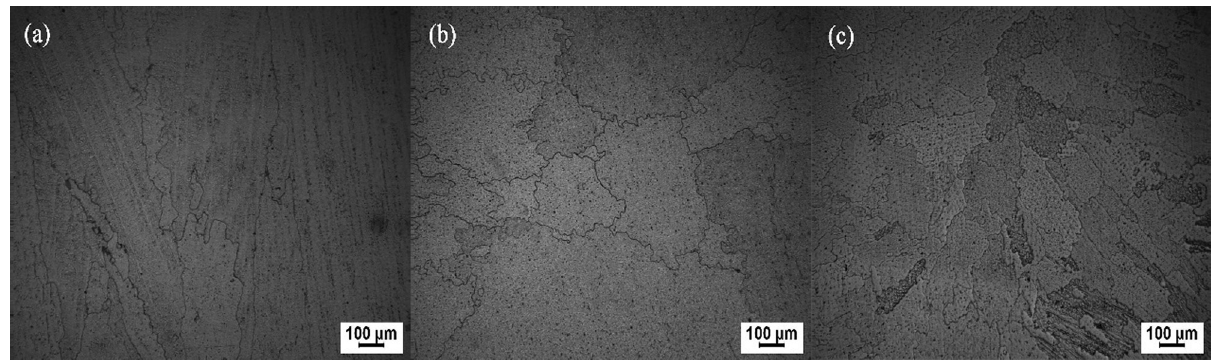
Figure 17: Microstructures of weld with di ff erent positions of cooling pipe. ( a ) Conventional welding; ( b ) single trailing cooling and ( c ) combined